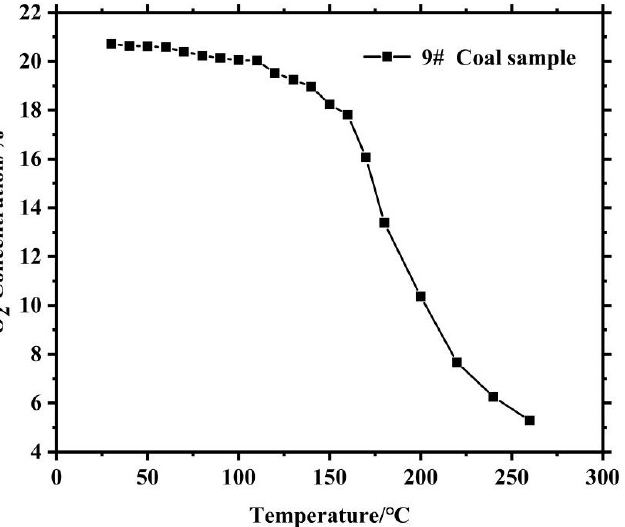
Figure 1. Programmed temperature rise—gas chromatography system.